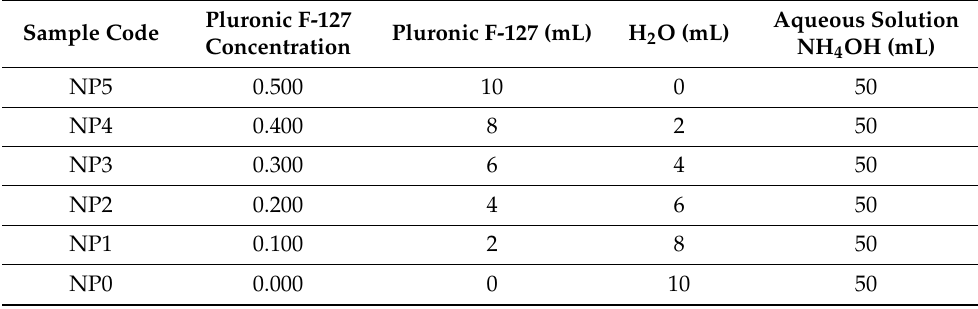
Figure 2. Synthesis of PL-127-coated MNPs. ( a ) Addition of Pluronic F-127 to the basic NH 4 OH solution, ( b ) addition of iron salt mixture to the basic NH 4 OH solution. Table 1. Aqueous solutions of NH 4 OH at different concentrations of Pluronic F-127.